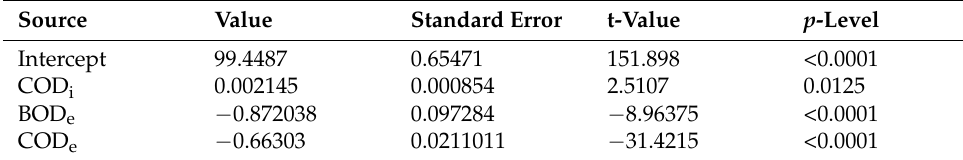
Table 7. Regression coefficients analysis for the Statgraphic model.